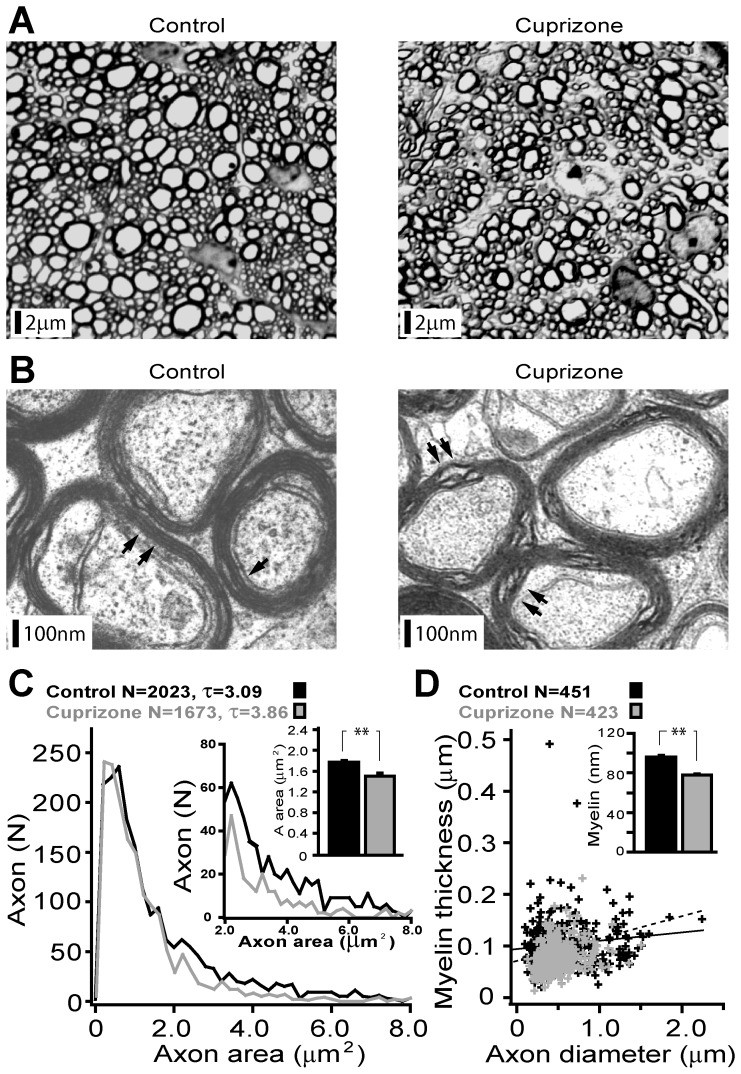
Light- and electron-microscopic analysis of ON reveals a decrease in the compactness and loss of myelin in the experimental mice.(A) Low power representative photomicrographs of ON from control and cuprizone-treated mice (TLB stained). Note less annular appearance of large diameter axons with a higher degree of intrinsic parcellation of the demyelinated nerve. (B) Electron micrographs of ON axons from control and treated mice. Along with a large number of myelinated axons (normal) with compact myelin sheaths consisting of several layers, axons covered with a loose myelin envelope of only a few lamellae were regularly encountered in the treated tissue (black arrows). (C) A summary plot of the distribution cross-sectional area of axons with insets highlighting divergence of this parameter for thicker axons (lower inset) and reduced mean cross-sectional area (upper inset) of axons in treated samples. (D) Graphical illustration of the relationship between myelin sheath thickness and axon diameter with regression lines and summary histogram of myelin thickness (inset) show a significant decrease in both parameters in treated mice.